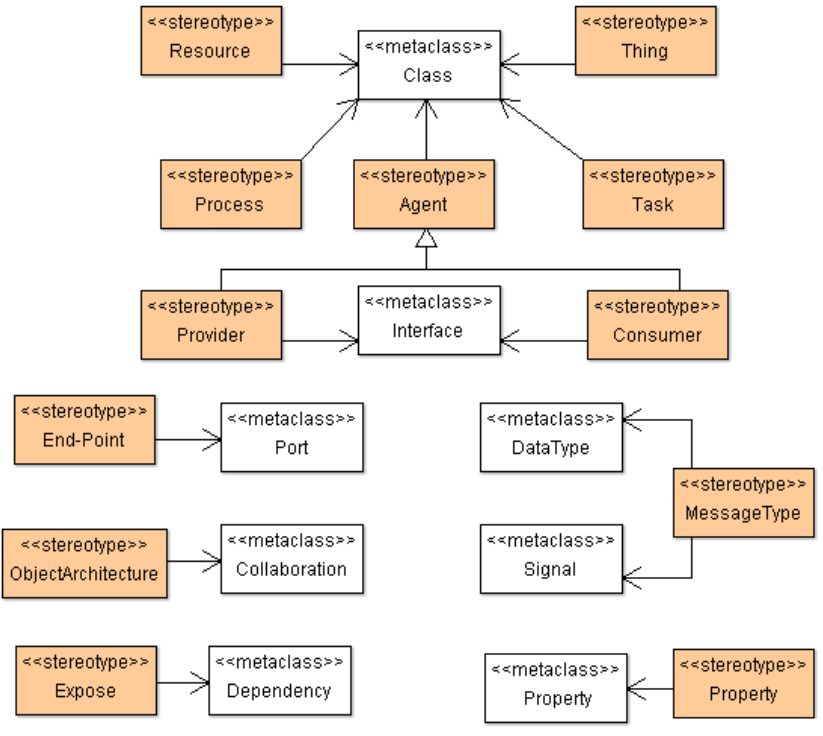
Figure 4. Part of the SsML profile focusing on defining a metamodel for modeling diverse functional aspects of the smart